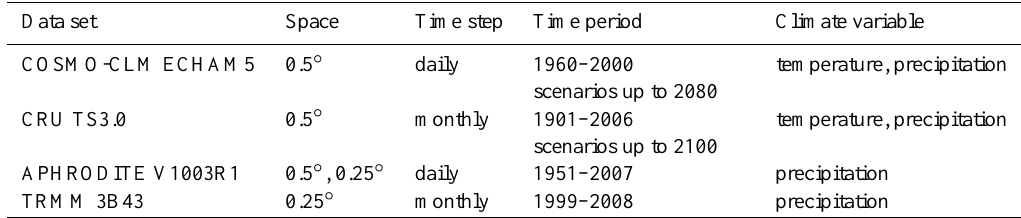
Table 2. Summary of global and regional gridded climate data time series used in this